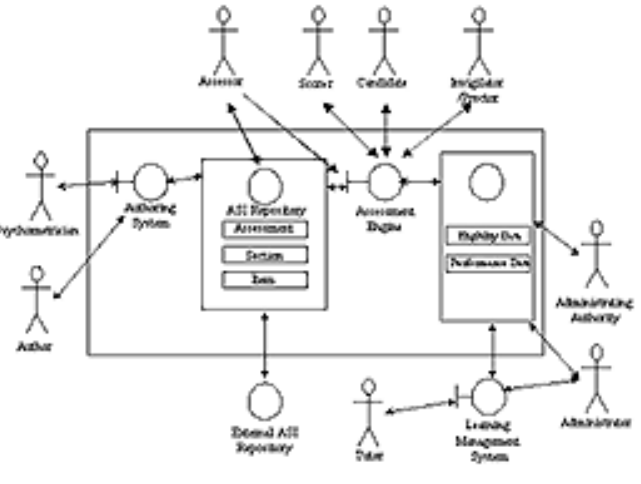
Figure 1: Assessment System